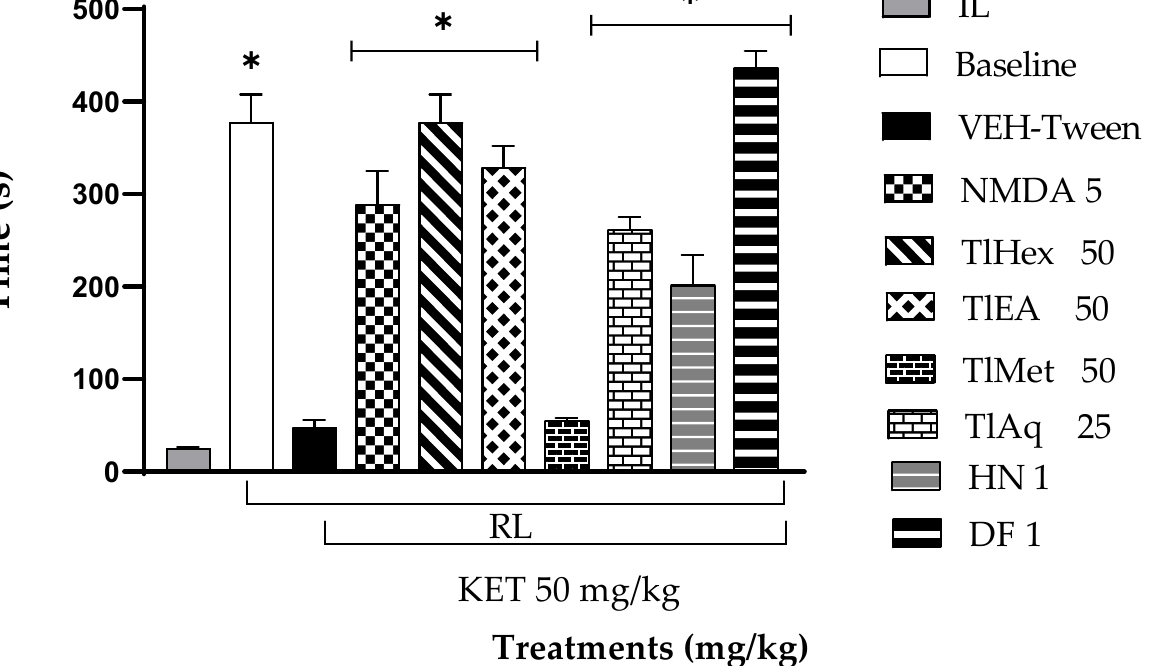
Figure 4. Effect of T. lucida extracts, herniarin (HN), and dimethylfraxetin (DF) on acute schizophrenia-like symptoms induced with KET 50 mg/kg i.p., in the Passive avoidance test (PAT) in mice. ANOVA followed by Dunnett’s Test ( x ± S.E.M., n = 5) with * p < 0.05 compared to the VEH-Tween group. RL = retention latency; IL = initial